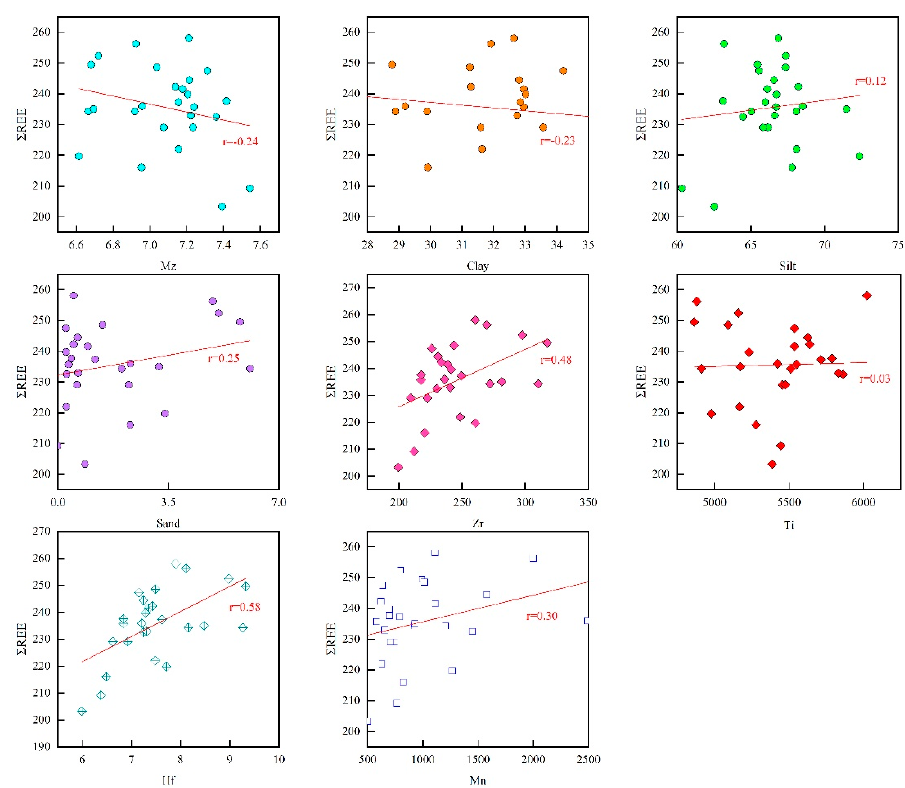
Figure 7. Correlation and linear regression curves of Σ REE with Mz, Mn, Ti, Zr, and Hf.